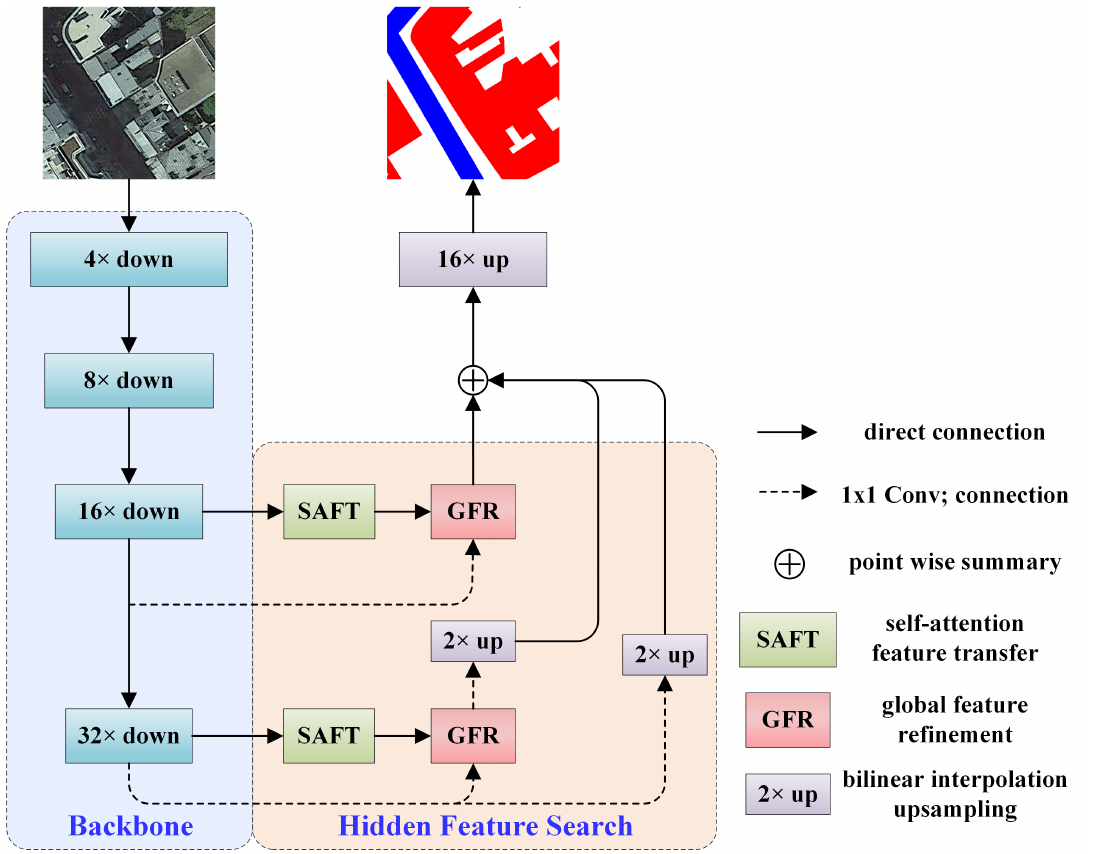
Figure 1. Non-Local Feature Search Network